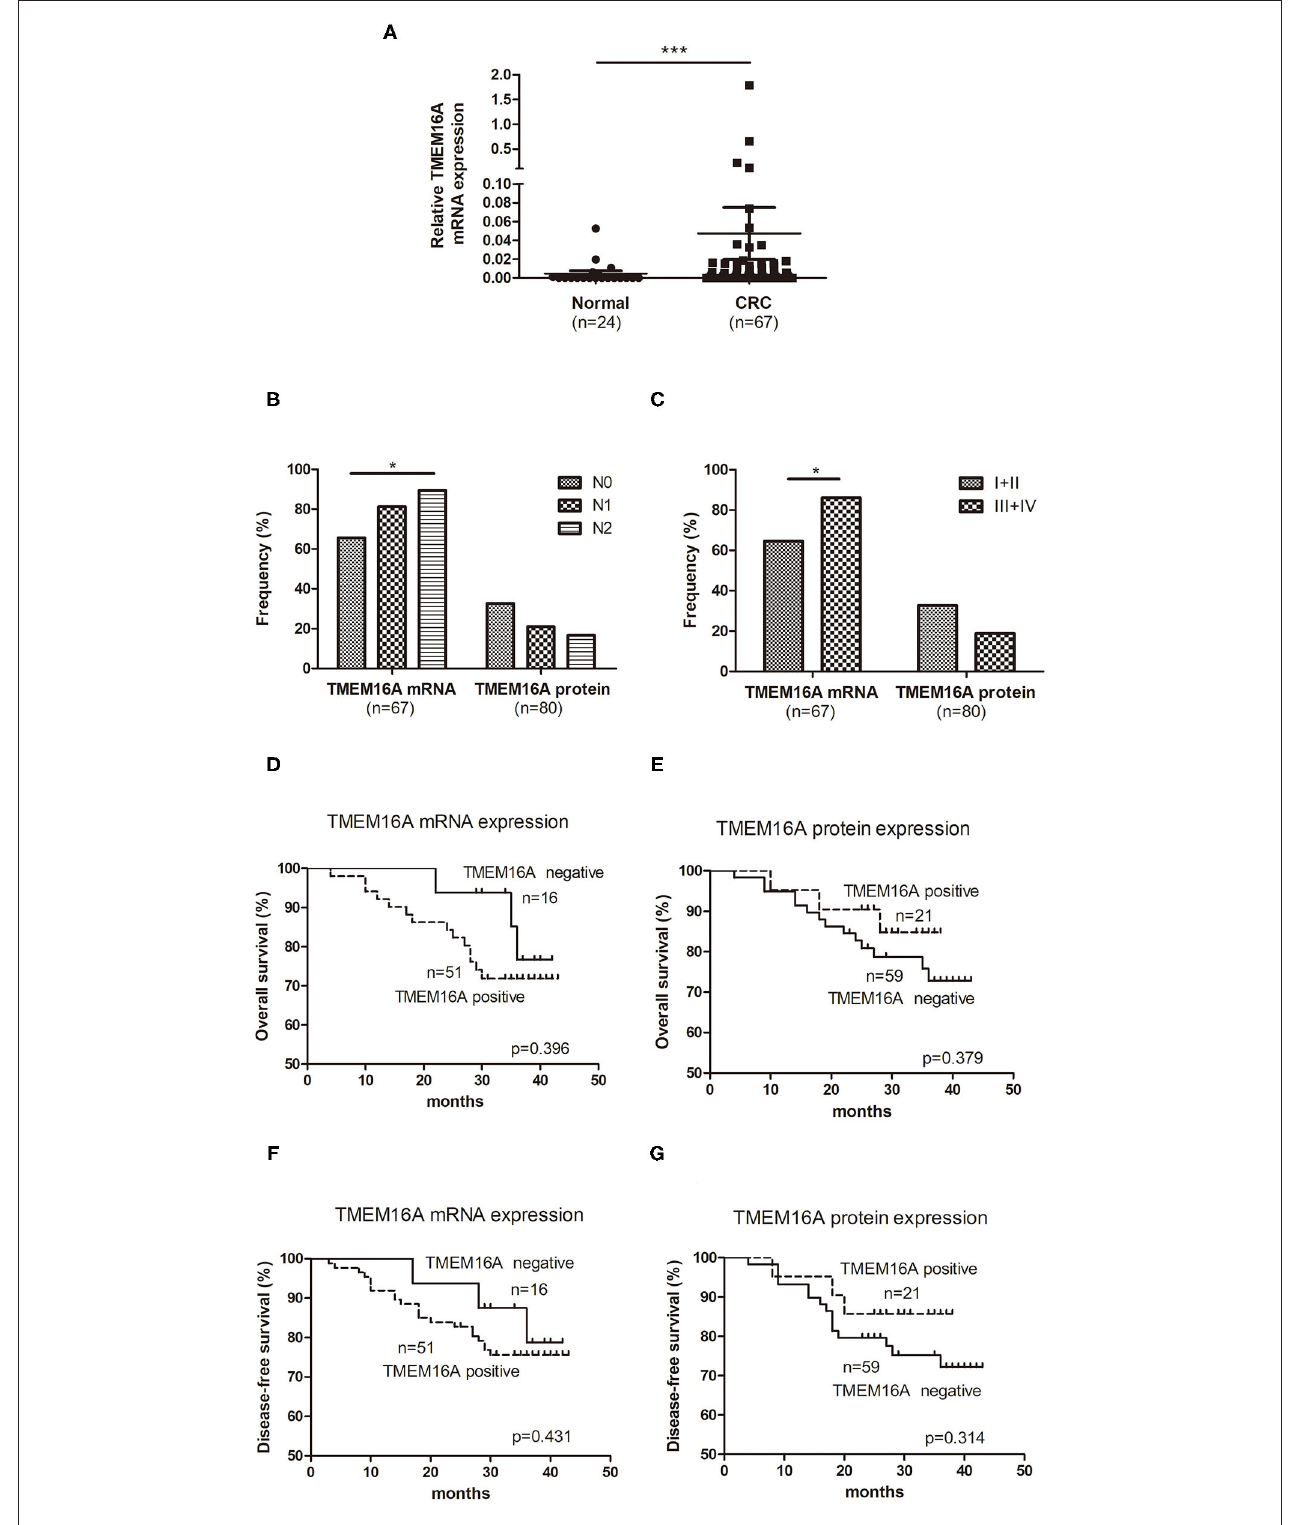
FIGURE 2 | Expression of TMEM16A in colorectal carcinoma and its correlation with overall survival. (A) Quantitative RT-PCR results showed that the expression of TMEM16A in colorectal cancer was significantly higher than that in normal colorectal tissue (*** P < 0.0001). (B) Positive rates of TMEM16A protein expression